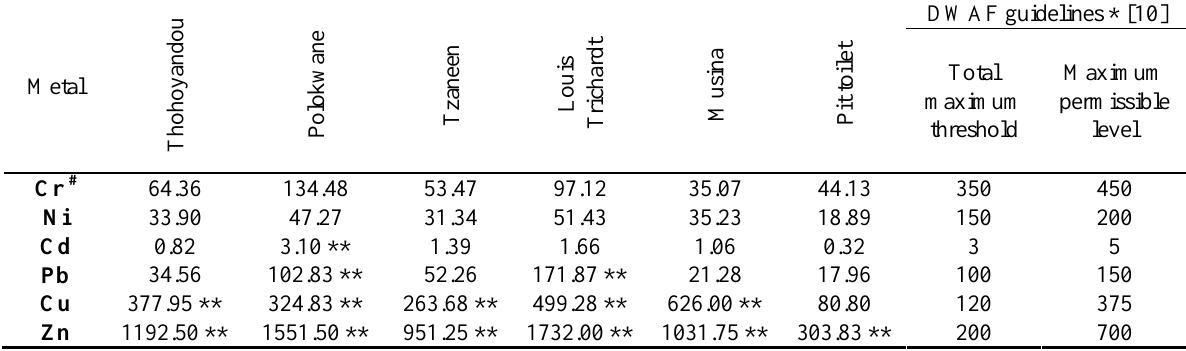
Table 1. The heavy metals in municipal sewage sludge (mg/kg dry